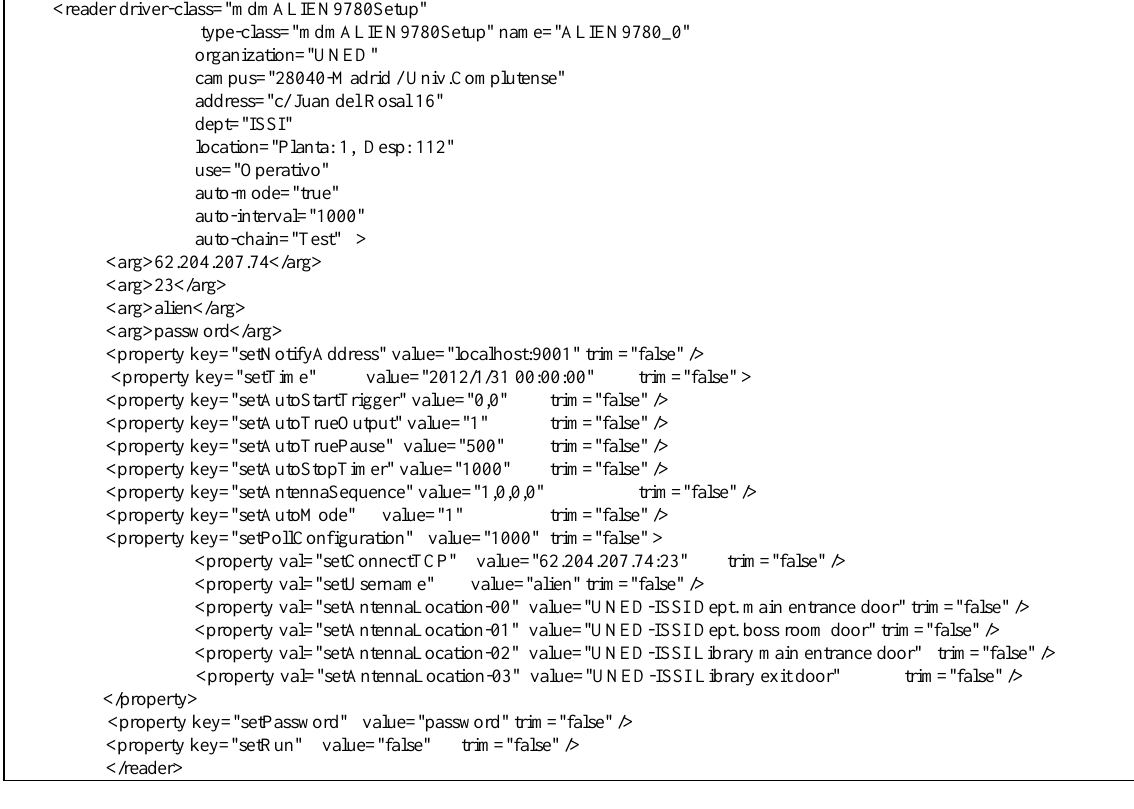
Table 2. MARC schema configuration of ALIEN RFID